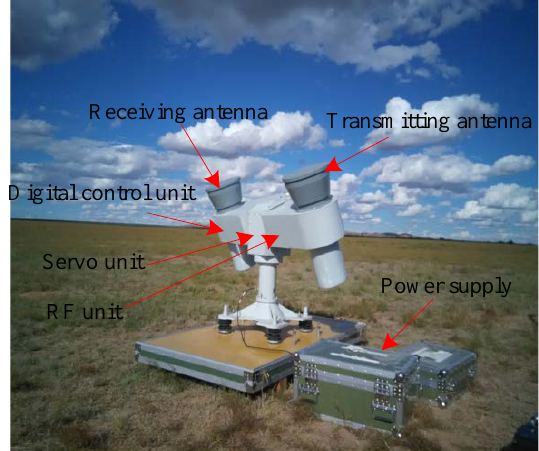
Figure 2. The transponder in the calibration field.